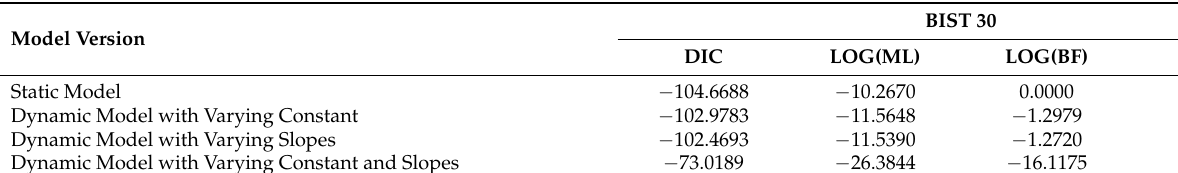
Table 7. Bayesian models: posterior odds ratios and Bayes factors.